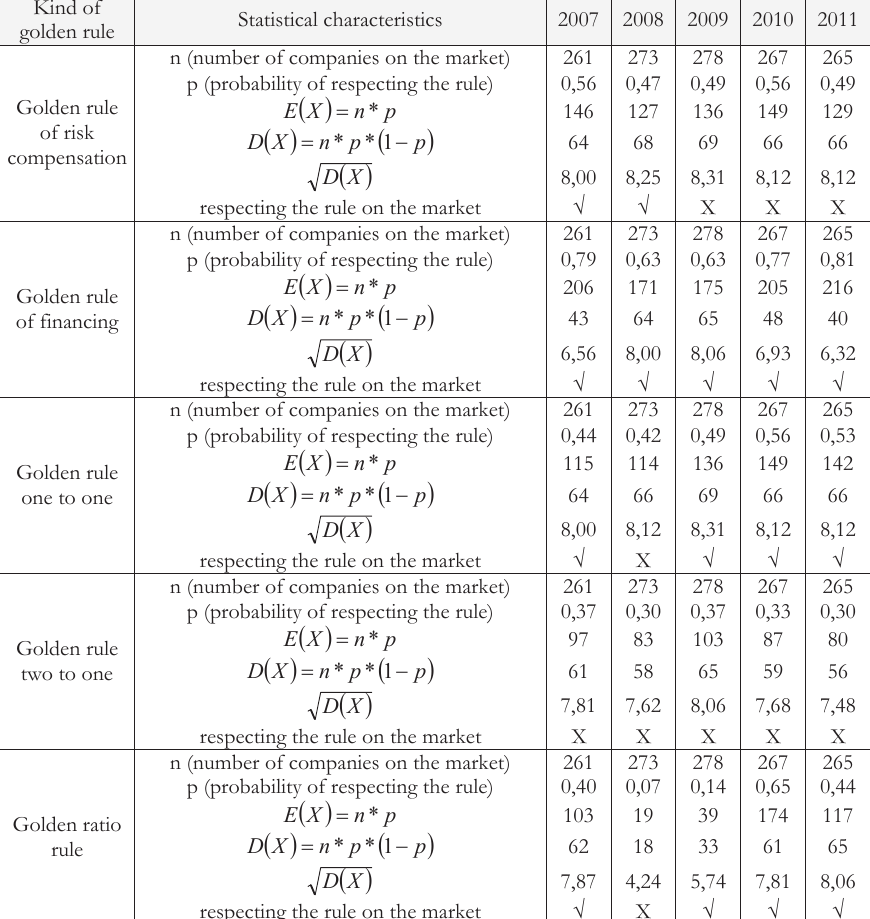
Tab. 4 – Statistical characteristics of binomial distribution for number of companies respecting golden rules of financing. Source: own research.